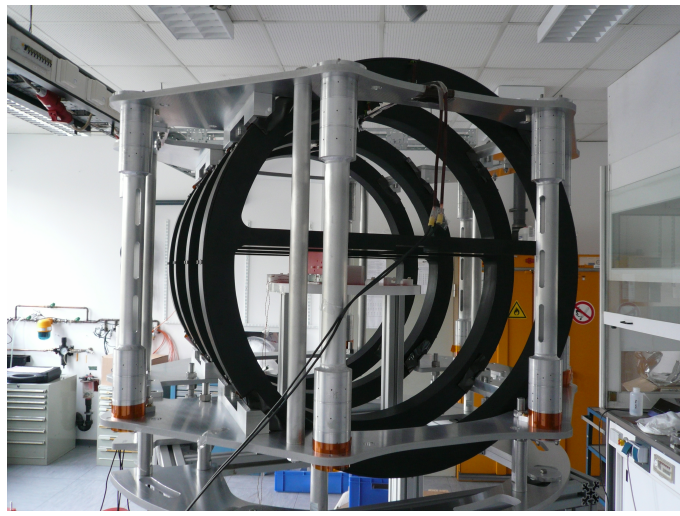
Figure 3. Fully assembled magnet system in the